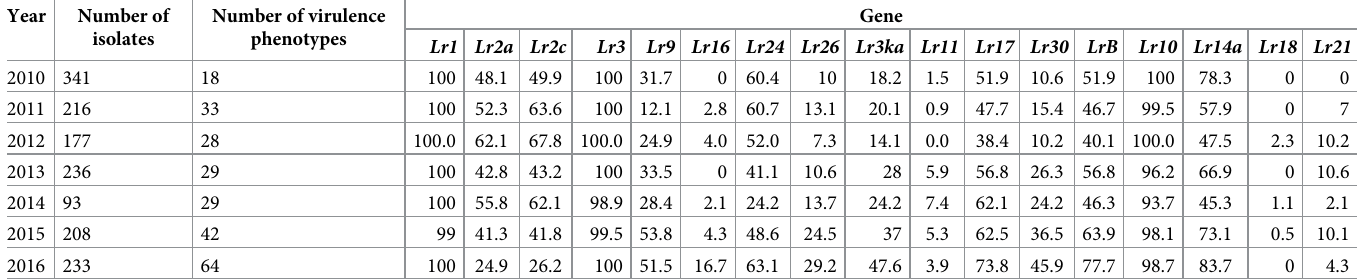
Table 1. Frequency of virulence to 16 leaf rust resistance genes in the Puccinia triticina inoculum mixture used to inoculate field screening nurseries in Canada between 2010 and 2016.